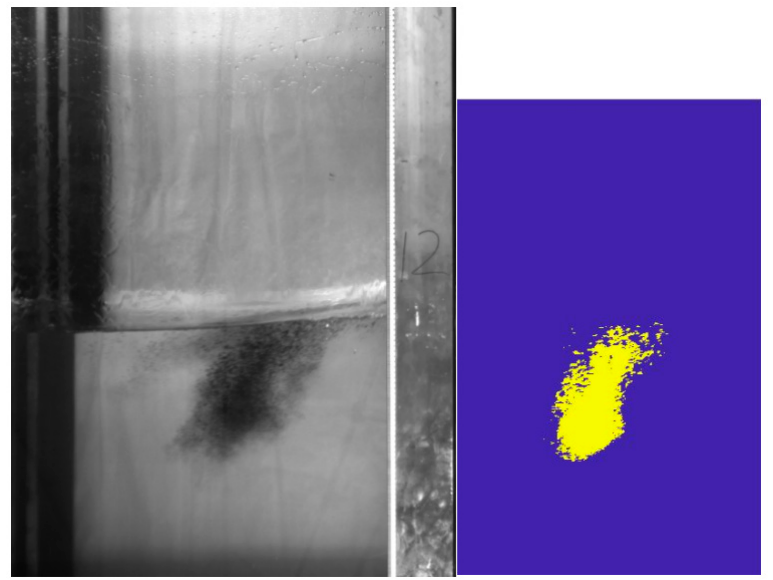
Figure 15. Spilled oil in the deepest position of observation area under 35 cm breaking wave.